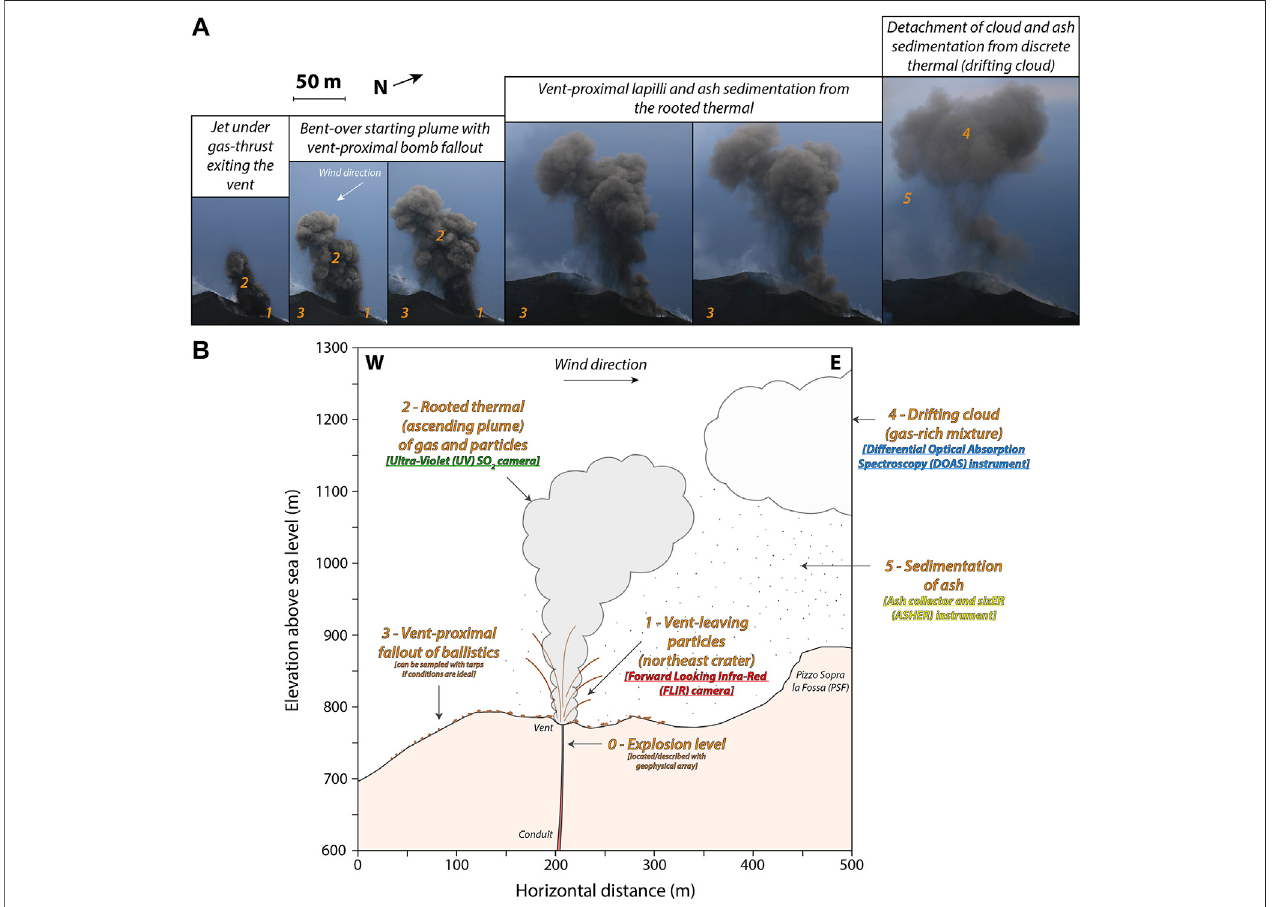
FIGURE 2 | (A) Sequence of pictures of a Type 2a explosion at Stromboli volcano, representing the evolution of eruptive products (ballistics and plume) in the atmosphere since the explosion level. Orange numbers are described in (B) . Terminology is based on Turner (1962), Turner (1969), Slawson and Csanady (1967). (B) Sketch of the different steps (marked in orange) of a normal explosion at Stromboli. Each step can be sampled and/or measured by different techniques and/or strategies, which are listed in the text. Instruments used in our fi eld experiments are underlined in different colors following the one used in Figure 1 .